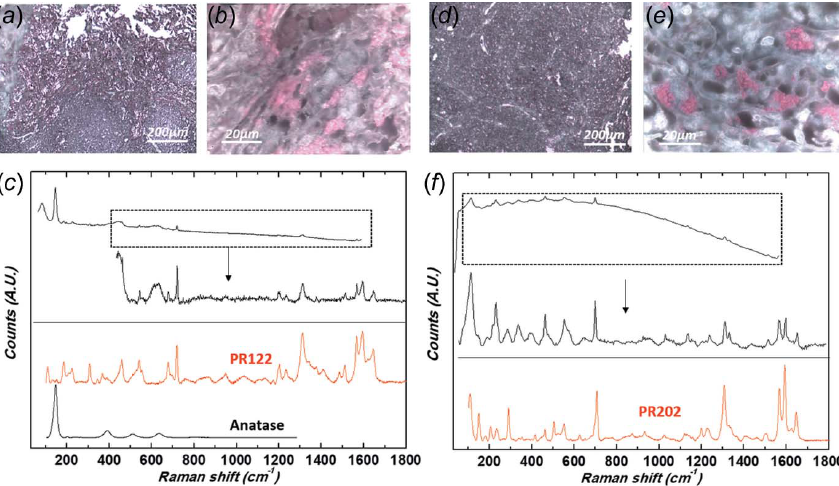
Figure 10 Raman spectroscopy: identification of quinacridone. ( a , b ) Optical micrographs of patient 5’s biopsy at two different magnifications [( a ) 10 (cid:4) and ( b ) 100 (cid:4) ] revealing the presence of micrometre-size red and white pigments, mixture of PR122 and TiO 2 . ( c ) Corresponding Raman spectra (top spectrum: no correction of the luminescence background; bottom spectrum: baseline corrected). Reference spectra are also given as comparison: PR122 C.I. 73915, Polycyclic pigment, Quinacridone from the Soprano spectral library, anatase (TiO 2 ) downloaded from the RRUFF spectral library (ID R110109, 780 nm). ( d , e ) Optical micrographs of patient 8’s biopsy at two different magnifications [( d ) 10 (cid:4) and ( e ) 100 (cid:4) ] revealing the presence of micrometre-size red pigments PR202. ( f ) Corresponding Raman spectra. Top spectrum is presented as collected (no correction of the luminescence background), bottom spectrum is baseline corrected and the spectral range adapted to highlight the signature of the red organic pigment. Reference spectra are also given as comparison: PR202 C.I. 73907, Polycyclic pigment, Quinacridone from the Soprano spectral